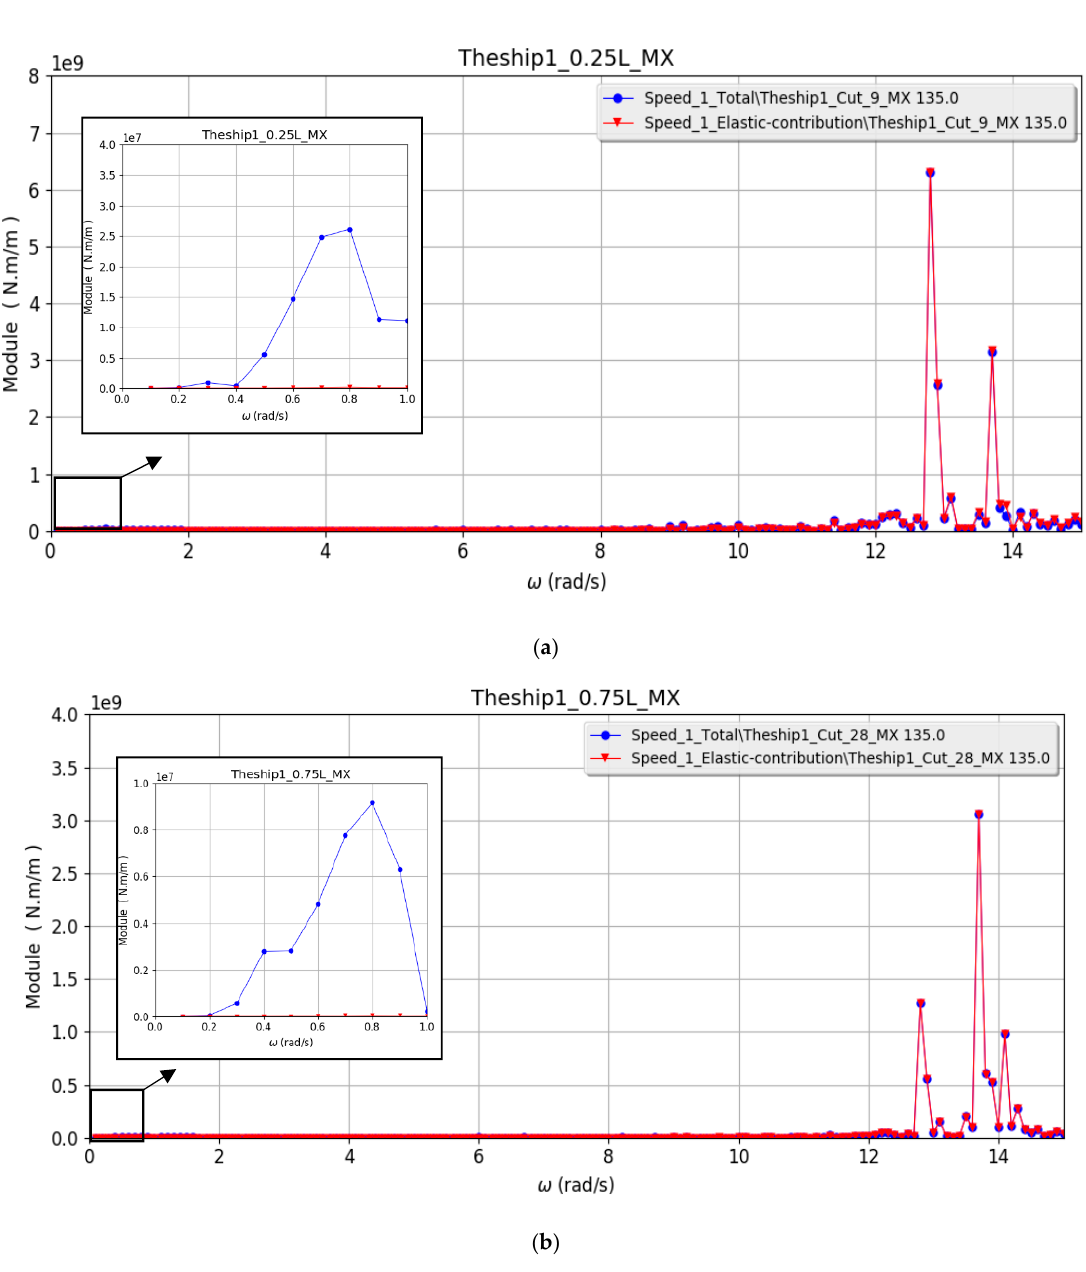
Figure 11. Torsional moment in oblique waves at ( a ) 0.25 L and ( b ) 0.75 L.